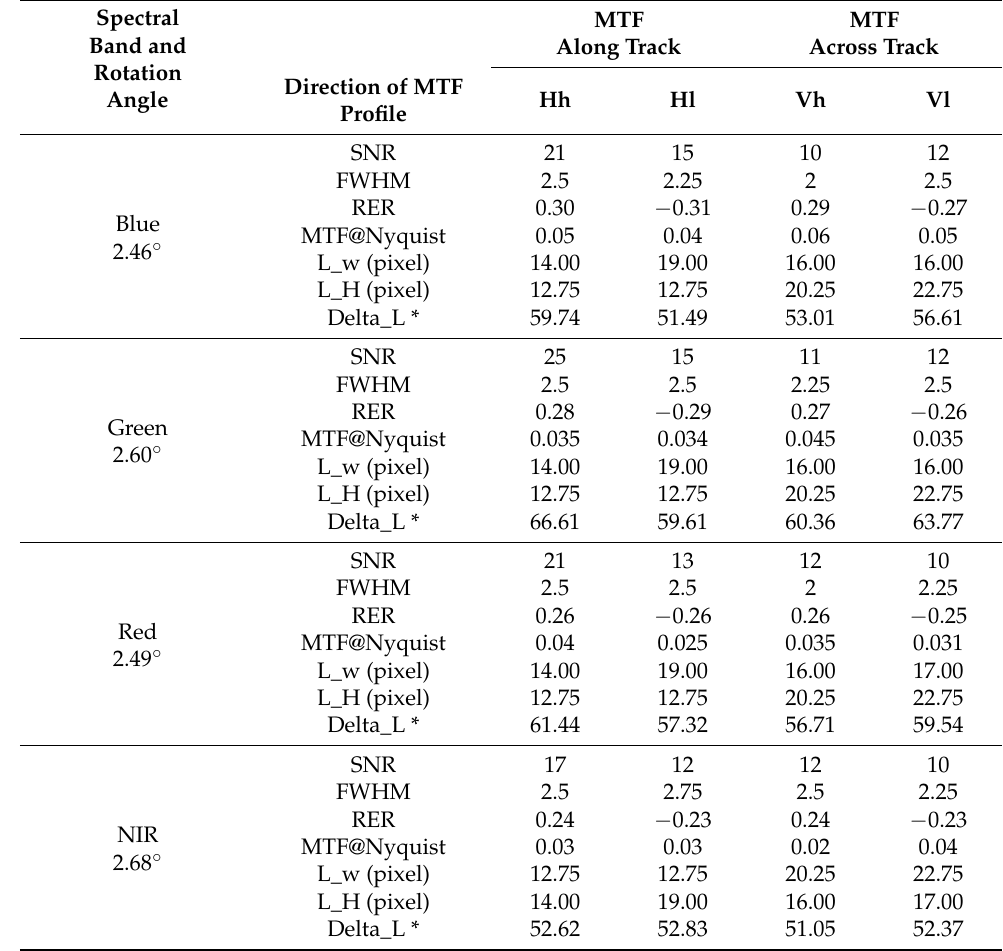
Table 5. The MTF results obtained from SkySat-17 BAS data acquired on 29 Dec 2020 over the